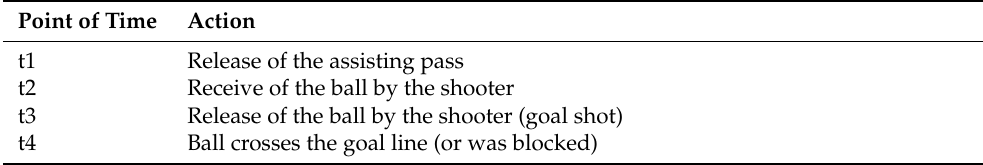
Figure 2. ( a ) Experimental setup: two cameras filmed the games 13 m above the water surface. ( b ) The smaller camera GoPro (right side) and the high-speed camera on the left side. In general, the playing behavior of the attacking and defending team was only ana- lyzed in relation to the position attacks (during 6-vs.-6 position attack and 6-vs.-5 man-up attack) within these game zones. An analysis of the swimming bridging the midfield (transition) was not carried out. Table 2. Overview of the used point of